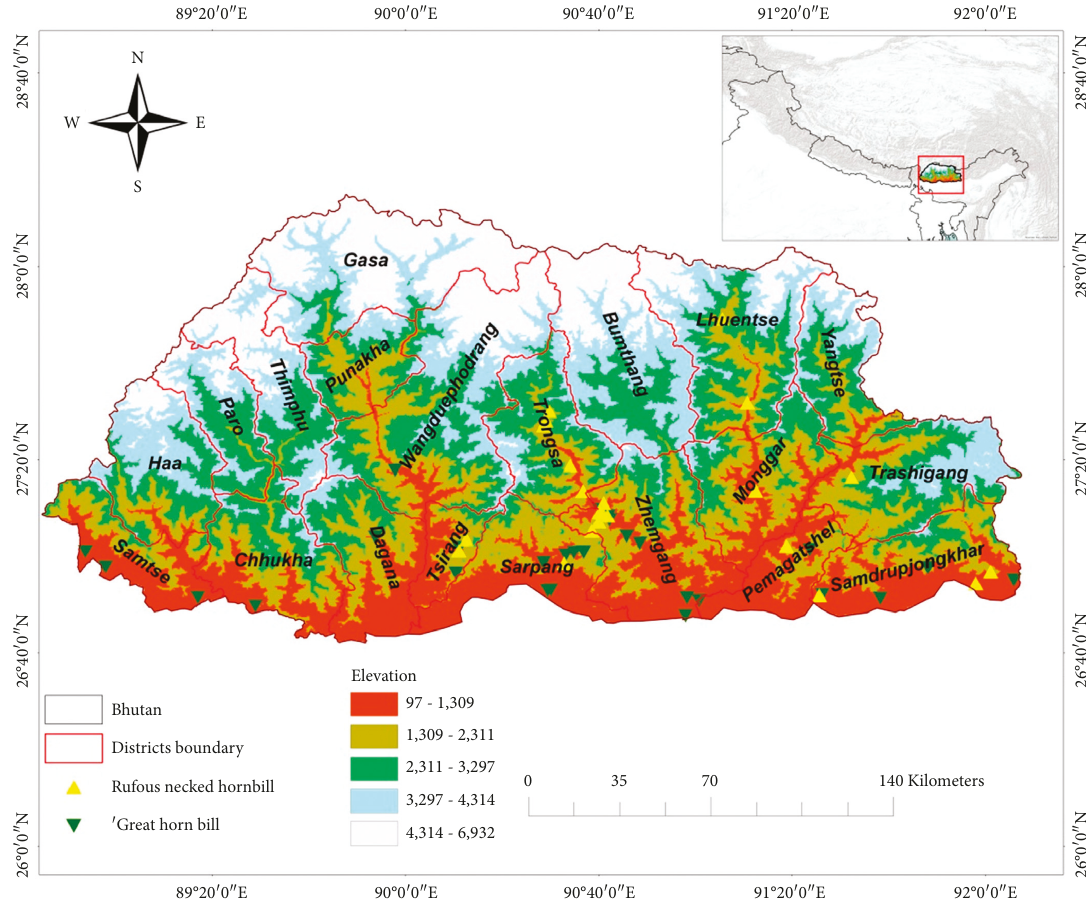
Figure 1: Location map of the study area with occurrence location of